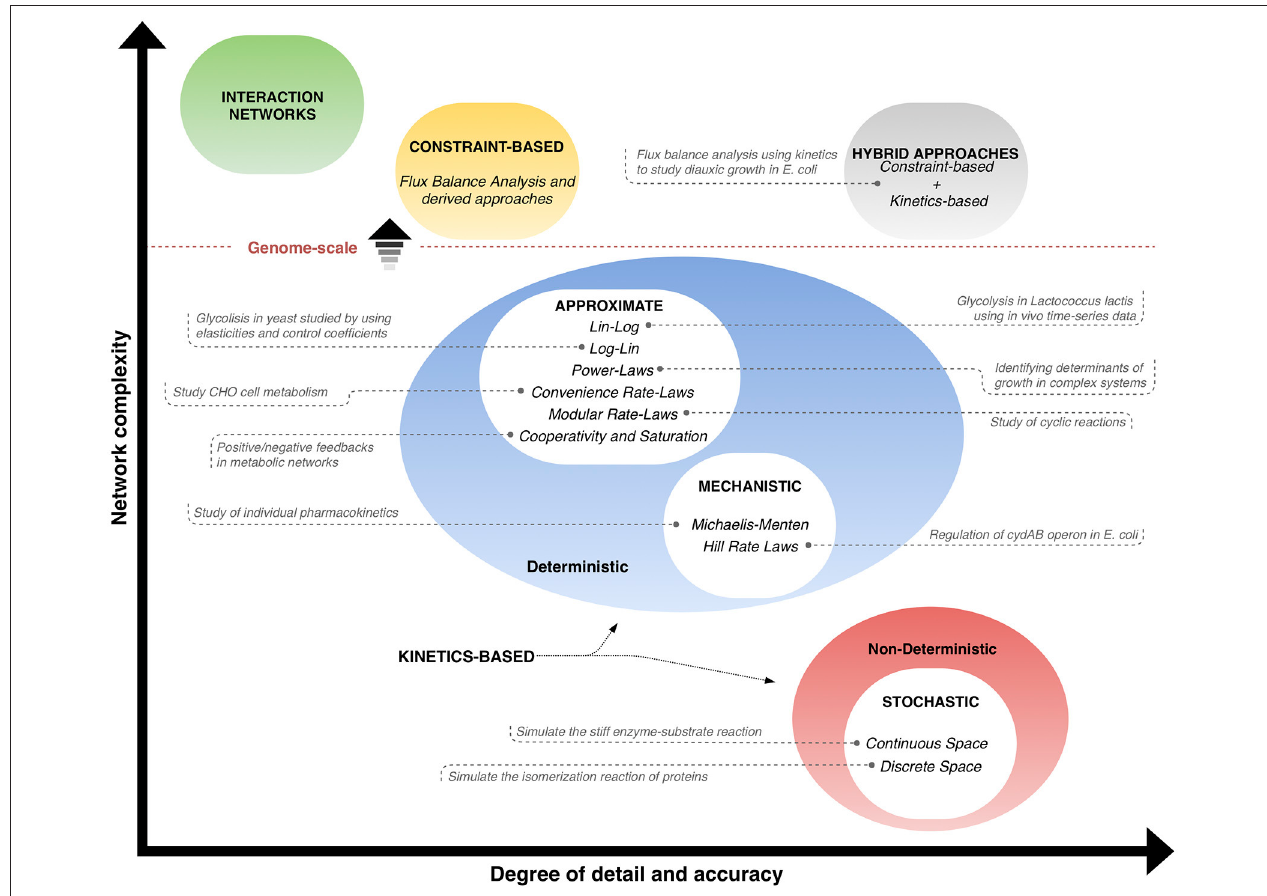
FIGURE 2 | Phenotype prediction approaches: interaction networks, constraint-based and kinetics-based methods can be classified qualitatively according to the level of detail and accuracy (horizontal axis), and the usual size of network (vertical axis). Position toward upper levels means genome-scale networks. Constraint-based and kinetics-based approaches can be joined in hybrid methods that aim at taking the best advantages of each of them. Examples of applications of kinetics-based and hybrid approaches are given (from Tables 1 , 3 , respectively).